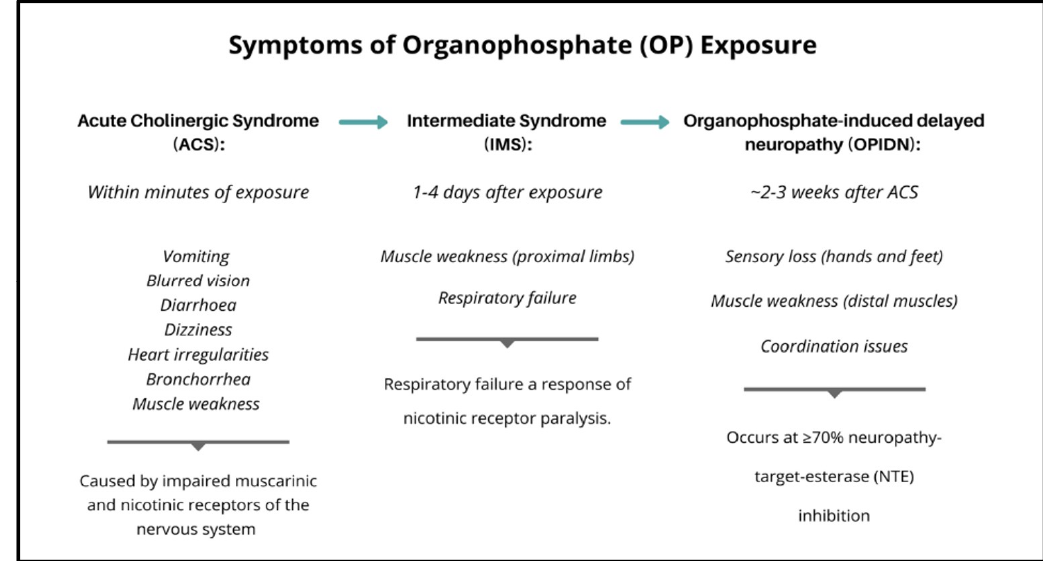
Figure 4. The symptoms of organophosphate (OP) exposure at progressive time points; acute cholinergic syndrome (ACS) occurs within minutes of OP exposure, symptoms of intermediate syndrome (IMS) display at 1–4 days after OP exposure, and symptoms of organophosphate-induced delayed neuropathy (OPIDN) occur ~2–3 weeks after OP exposure.